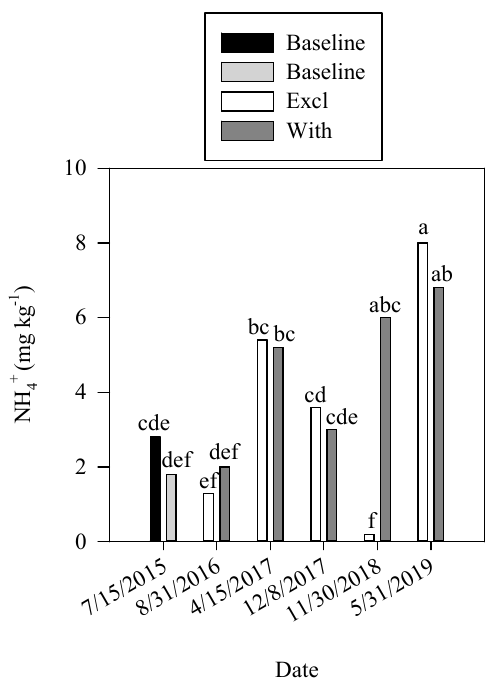
Figure 4. NH 4+ as a function of the interaction between sampling date and grazing in Pennsylvania site. Means followed by different letters are significantly different ( p -value ≤ 0.05).